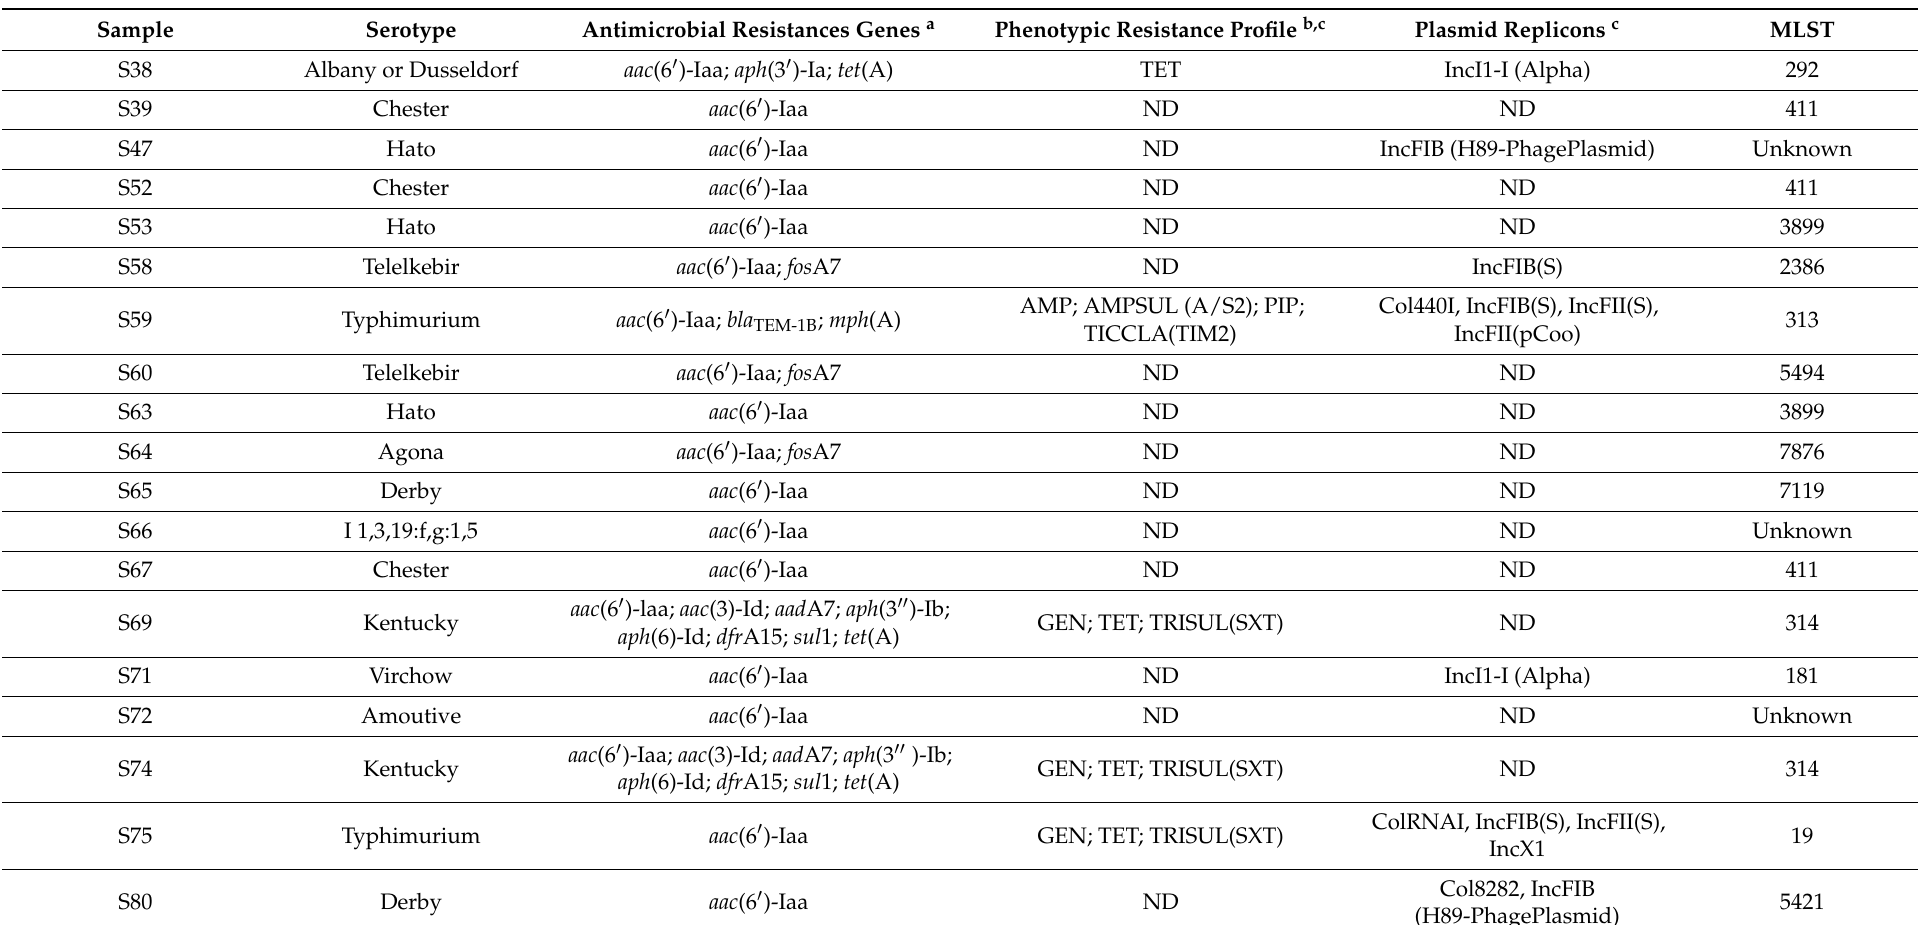
Table 1. Characteristics of Salmonella isolated from slaughtered